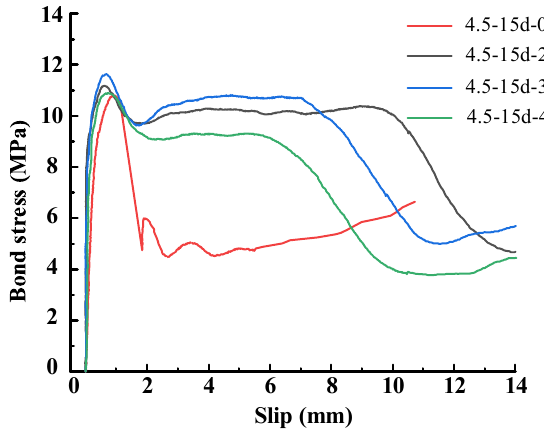
Figure 5. Representative bond stress-slip curves.